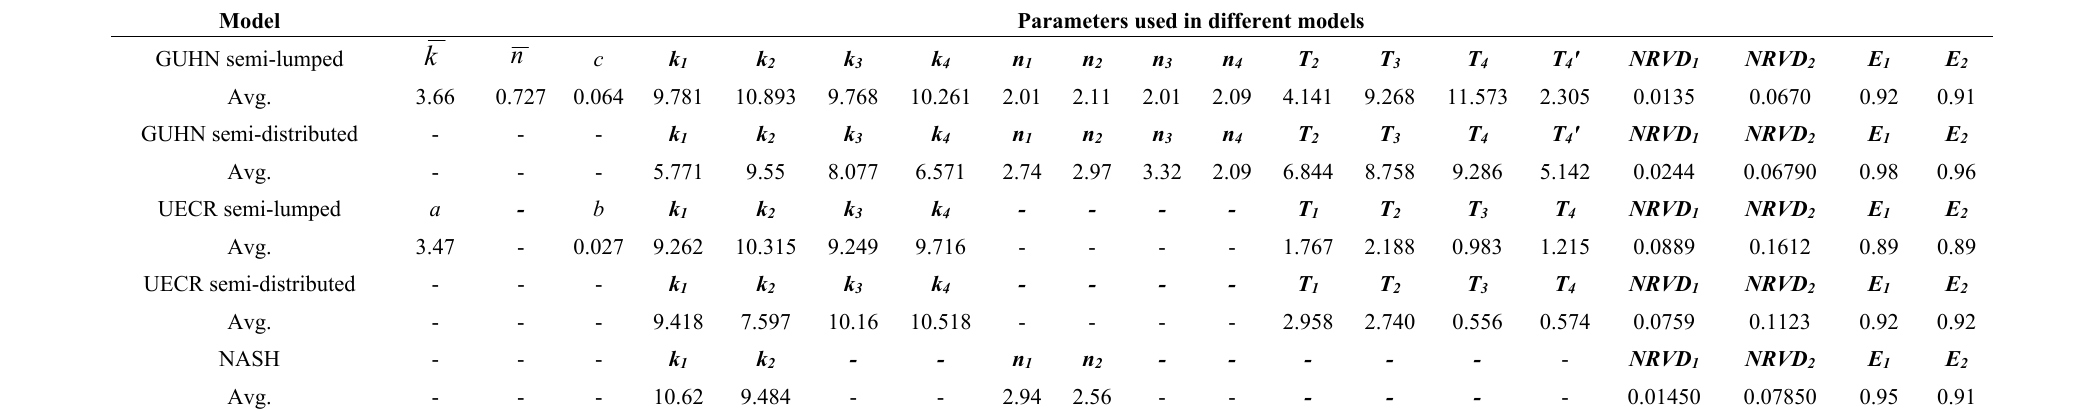
Table 5. Calibrated model parameters for different models.